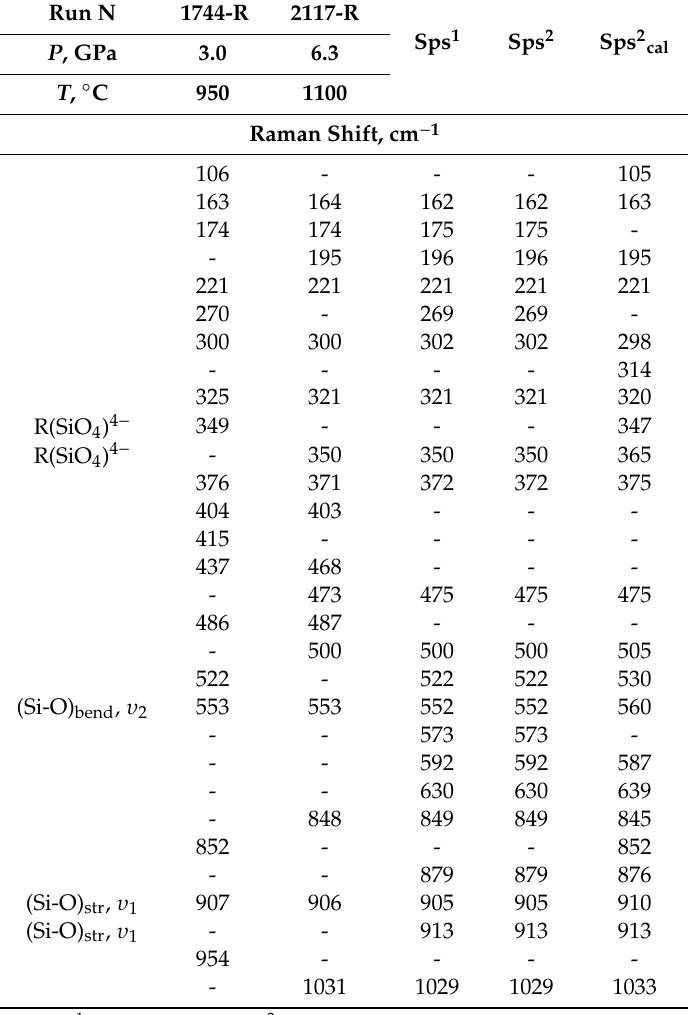
Table 3. Raman characterization of spessartine garnet, synthesized in MnCO 3 -SiO 2 -Al 2 O 3 system and previously published